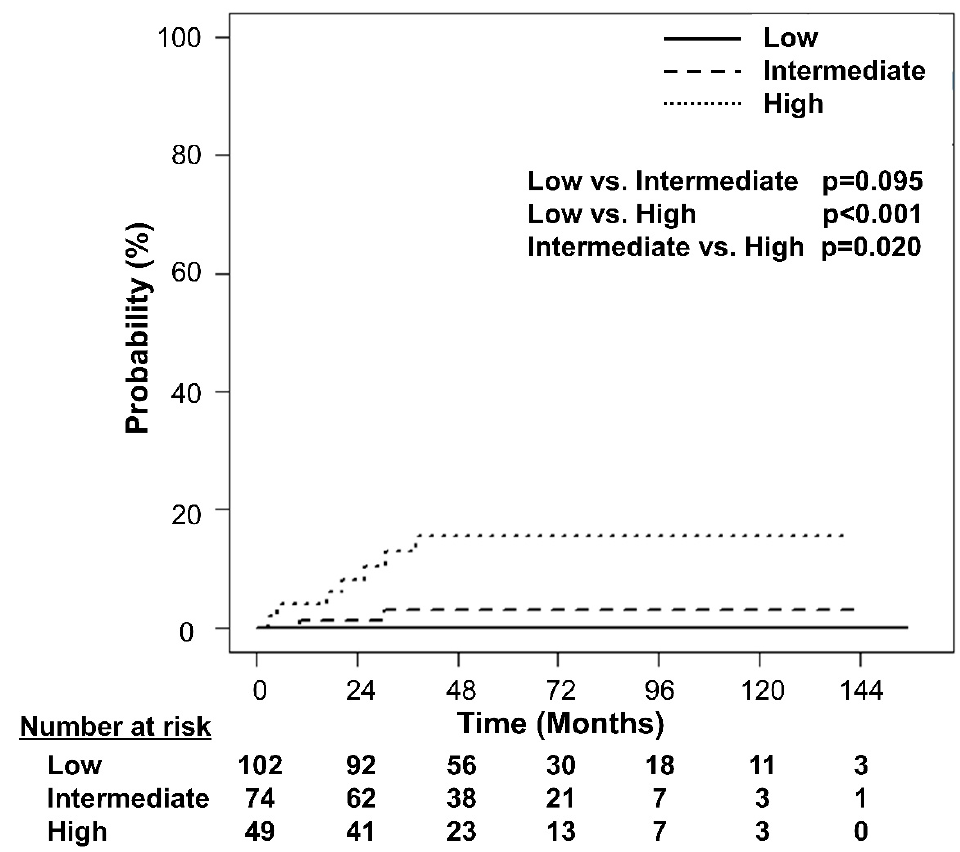
Figure 4. Cumulative incidence curves of the development of diabetes mellitus according to the risk groups defined by recursive partitioning analysis. groups defined by recursive partitioning